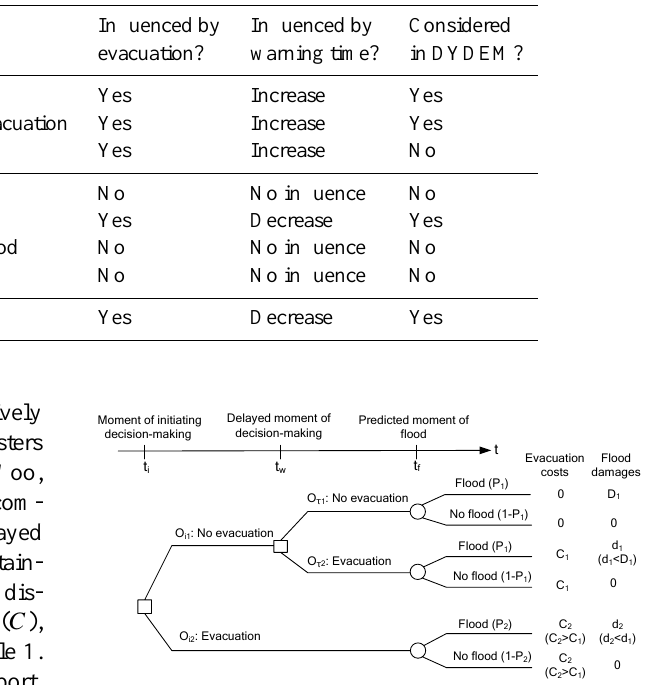
Fig. 1. Normally, t f is set as a target time (e.g. with enough lead time to evacuate the people) or the time of the worst predicted situation (e.g. the highest water level or largest flood flow rate). This may not be reasonable due to the fact that a dam-break flood may occur at any future time. There- fore, decision trees may not be sufficient for dynamic deci- sion making, since the predicted flood probability should be a stochastic process instead. The loss of life and properties could be underestimated if the flood occurs before the pre- dicted time, and vice